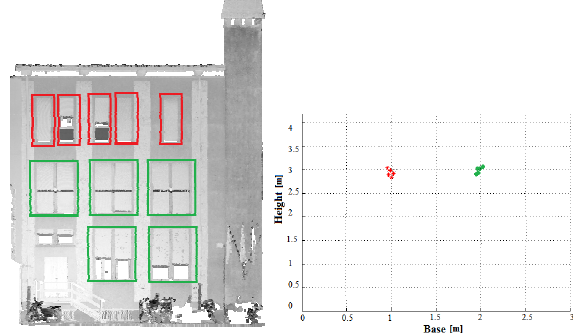
Figure 3. Example of a façade with two different window types (red and green) on the left and clustering results (right) using base and height of the bounding box of detected objects.